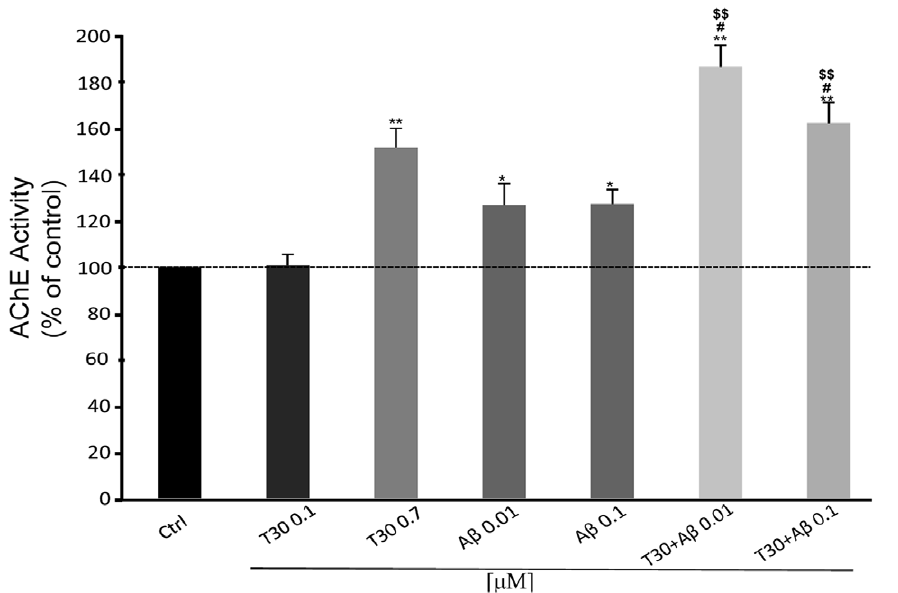
Figure 7. Bar graph showing the additive effect of b -Amyloid (A b ) and AChE C-terminus peptides of 30 amino acids (T30) on Acetylcholinesterase (AChE) activity. Cells were treated for 1 hour. Data are presented as the percentage of the mean 6 S.E.M. divided by the number of extant cells and obtained from independent experiments carried out on triplicates. * P , 0.05 and ** P , 0.01 vs Control; # P , 0.05 vs T30 0.1; $$ P , 0.01 vs A b . Dotted line shows basal AChE activity (Control 100%).